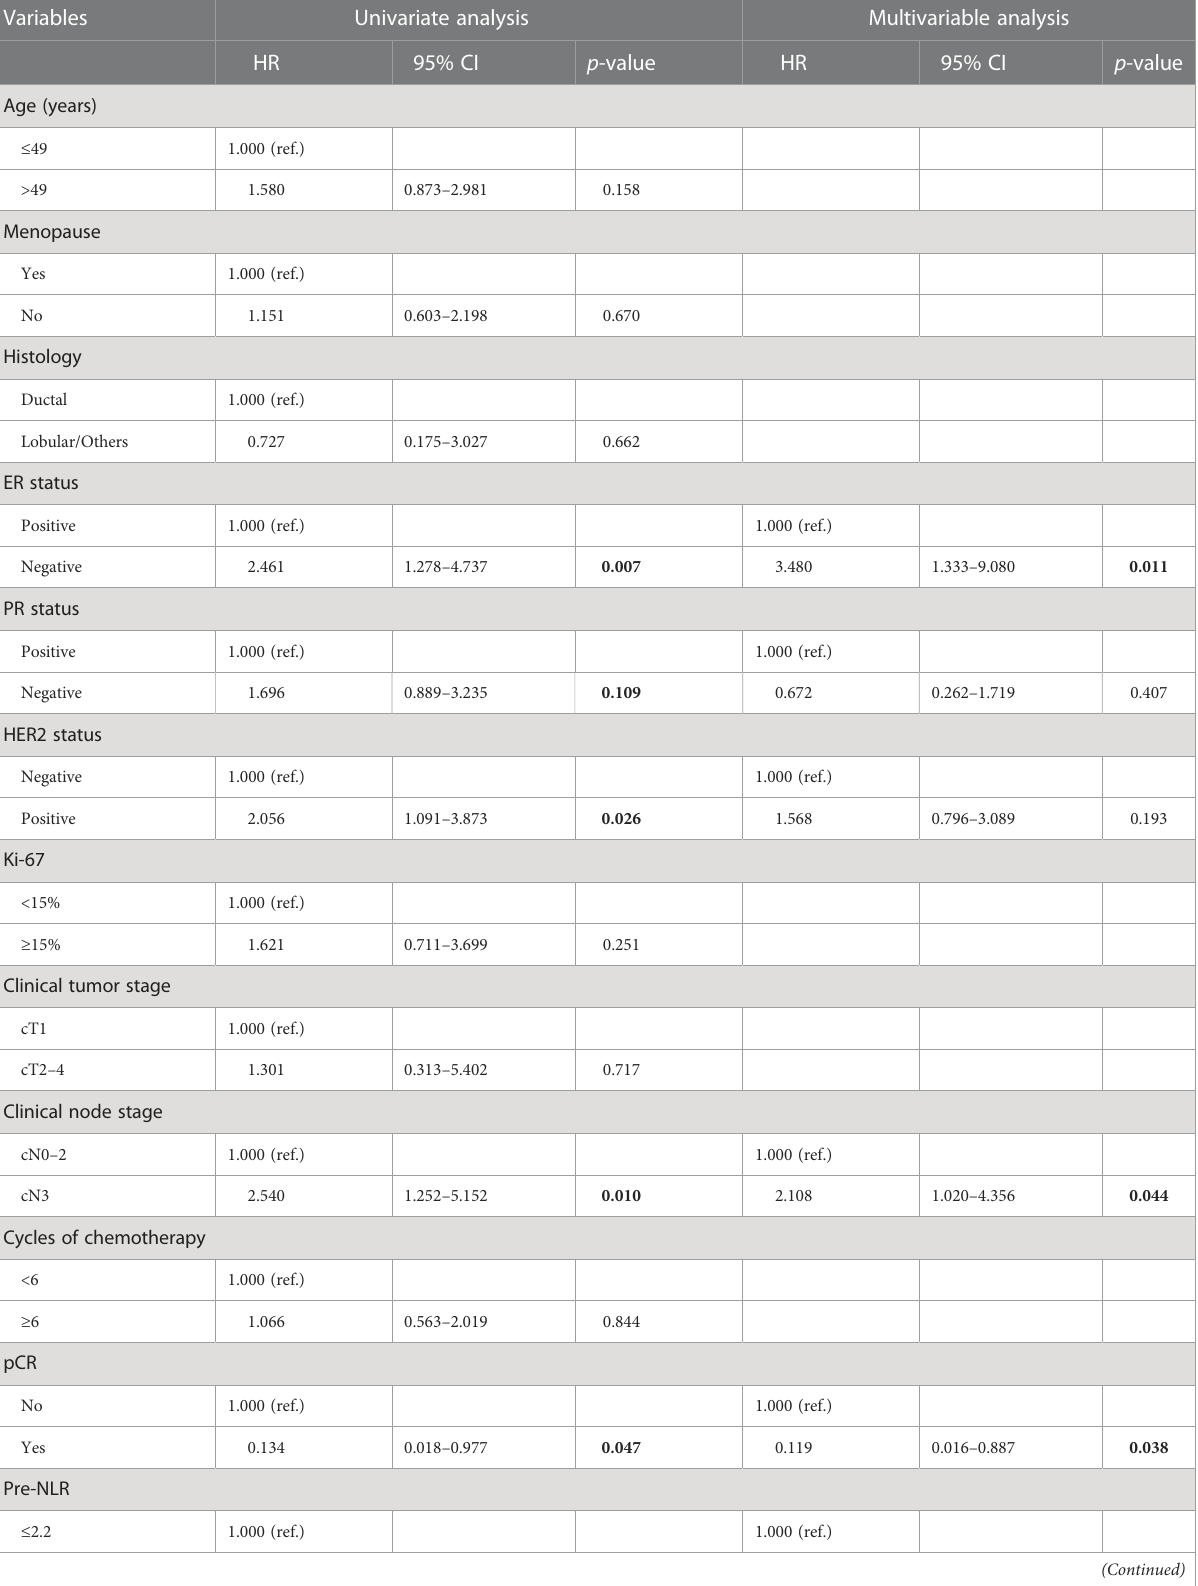
TABLE 2 Univariate and multivariable analyses of OS in the training cohort using the Cox